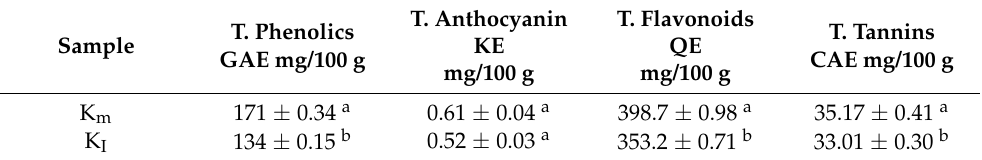
Table 3. Total phenolics, anthocyanin, flavonoids and tannins contents (dry weight bases) in methanol extracts of mature (K m ) and immature (K I ) fruits of K.